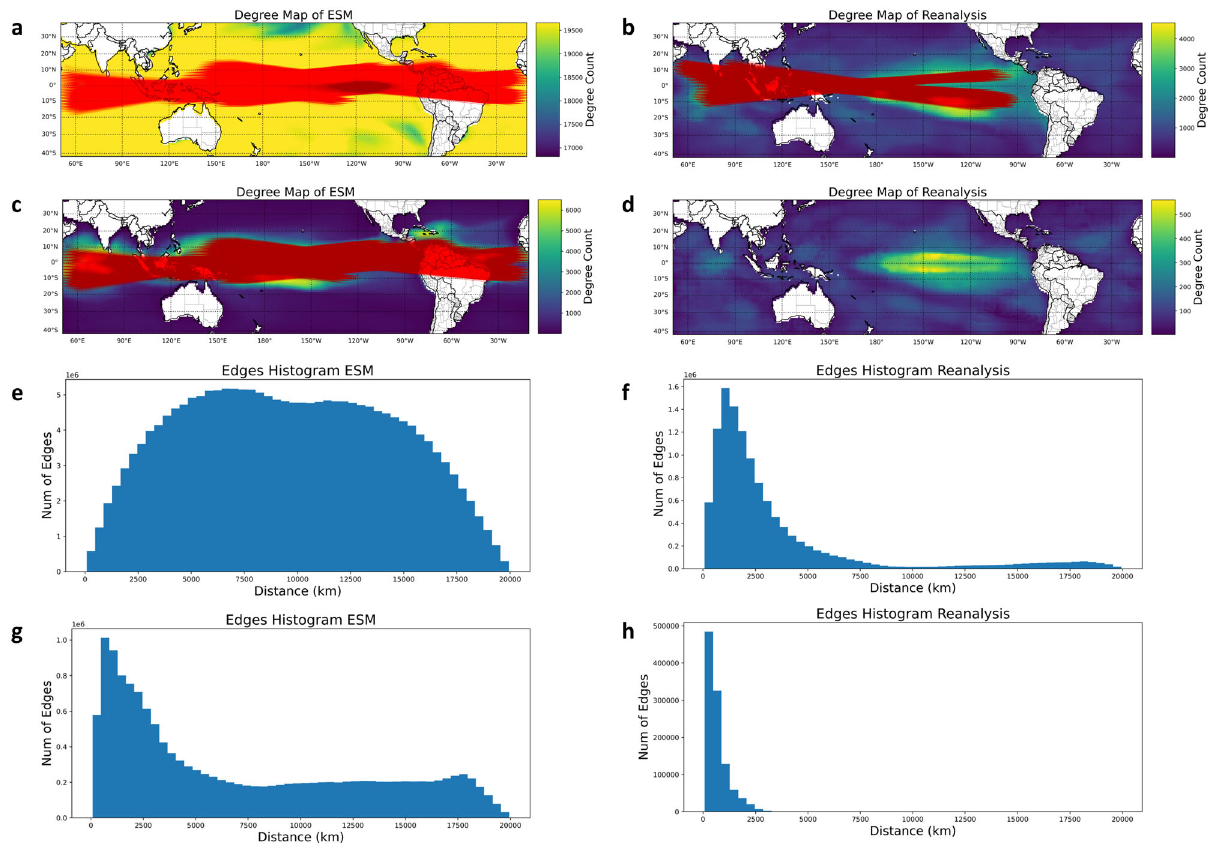
Fig. 4 | Teleconnections in space and time based on reanalysis and model- simulated link strengths and degree maps used to construct and interpret complex networks in climate. a , c Degree map and teleconnections for mean EarthSystemModel(ESM)seasurfacetemperature(SST).( a )correlationthreshold equalto0.5and0.9fordegreeandteleconnection. c correlationthresholdequalto 0.9 and 0.9 for degree and teleconnection. b , d Degree map and teleconnections